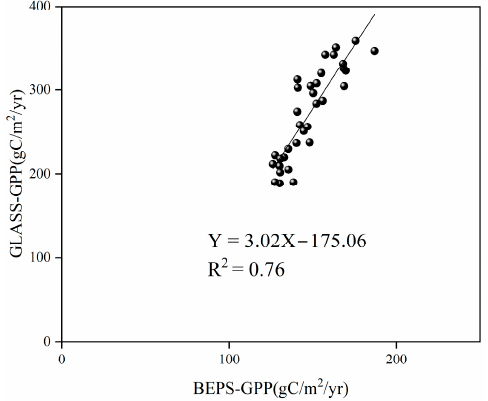
Figure 2. Correlation analysis between two GPPs products in the TRSR.